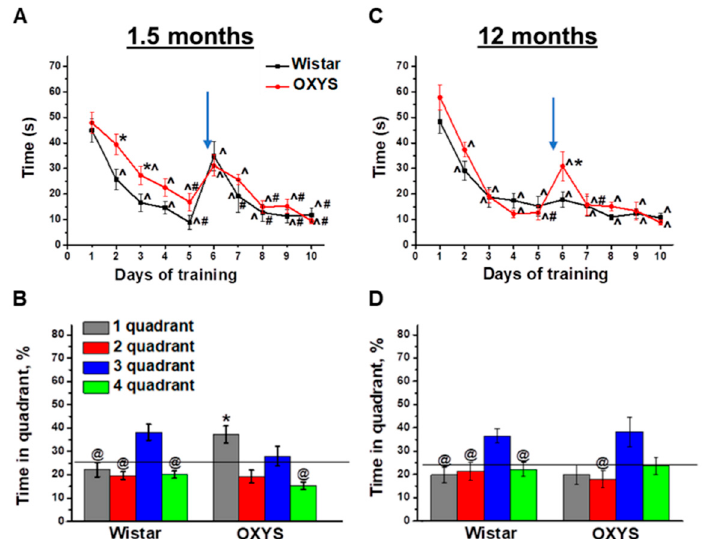
Figure 1. Morris ware maze (MWM) performance of OXYS and Wistar rats at 1.5 and 12 months of age. Time required for finding a submerged platform on subsequent training days for OXYS and Wistar rats at 1.5 months of age ( A ) and 12 months of age ( C ). In the probe trial, 1.5-month-old Wistar rats preferred the target third quadrant, whereas OXYS rats remembered the previous location of the platform in the first quadrant ( B ). At 12 months of age, Wistar rats preferred the target third quadrant to all other quadrants; this was not the case for OXYS rats ( D ). The data are presented as mean ± SEM, n = 8. * p < 0.05 for di ff erences between the strains; ˆ p < 0.05 for a comparison with the first day of testing; # p < 0.05 for a comparison with the sixth day of testing; @ p < 0.05 for a comparison with time in the third quadrant. The arrow indicates the move of the platform from the first to third quadrant. The black line ( B , D ) indicates the average time the rats should spend in each quadrant without